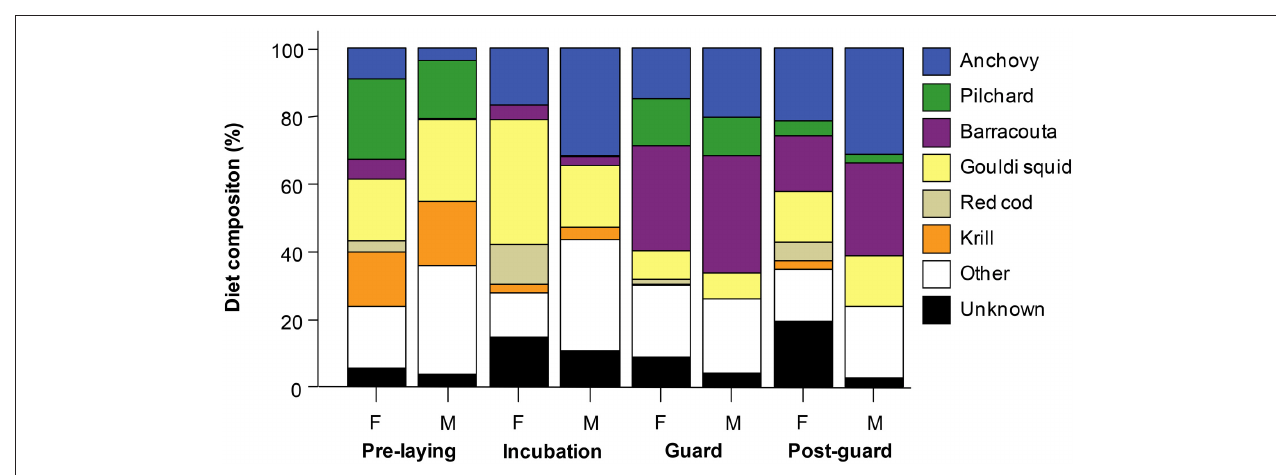
FIGURE 2 | Mean relative prey abundance (combining data on stomach contents for the 1995–2012 not continuously—see Table 1) in the diet of little penguins split by sex and breeding stage. Prey types with relative abundances < 3% have been grouped within “Other” category.